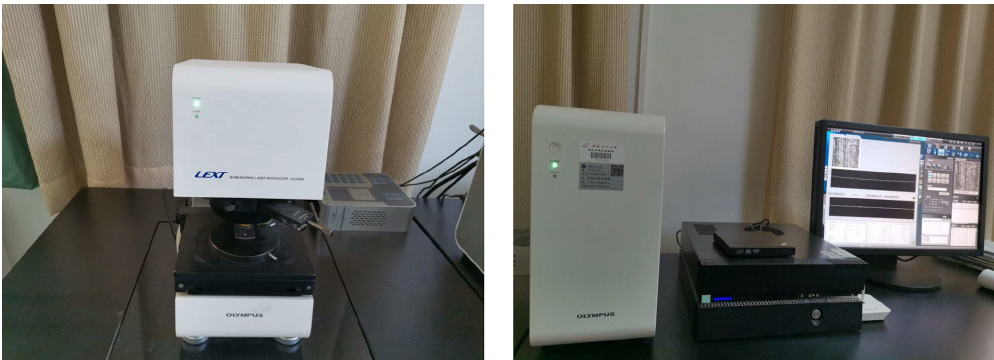
Figure 2. The 3D laser scanning confocal microscope